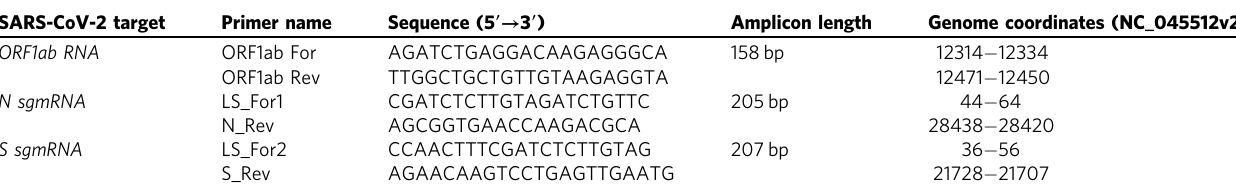
Table 2 Primer pairs designed in this study to target speci fi c SARS-CoV-2 RNAs. SARS-CoV-2 target